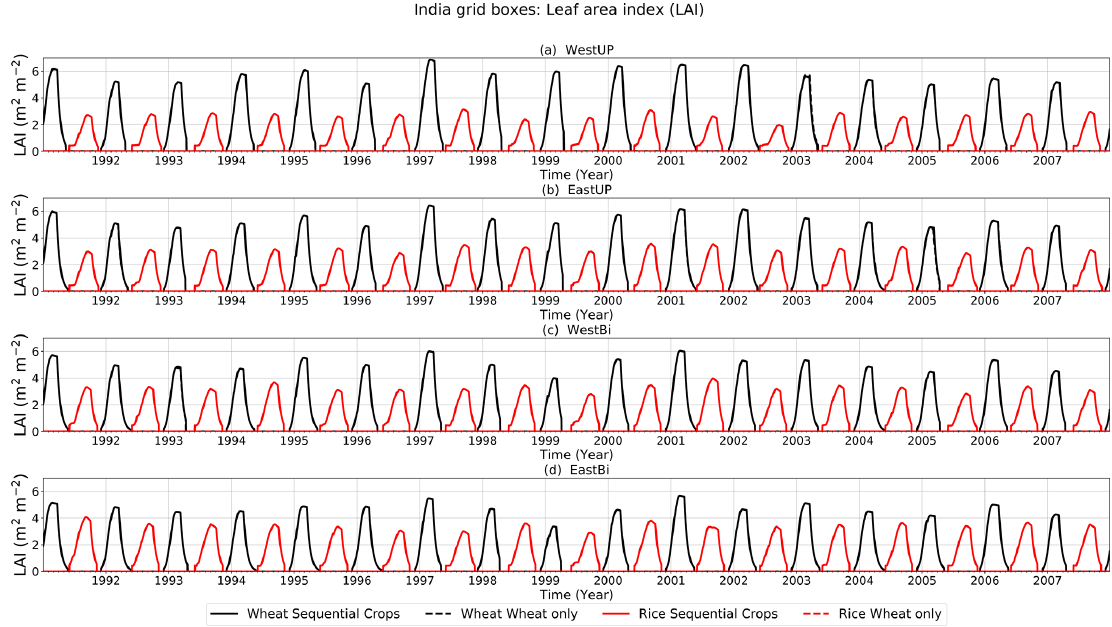
Figure B3. Time series of the LAI of rice (red) and wheat (black) at each of the India locations shown in Fig. 3. India-sequential is shown by solid lines and India-single is shown by dashed lines although they are indistinguishable from each other.